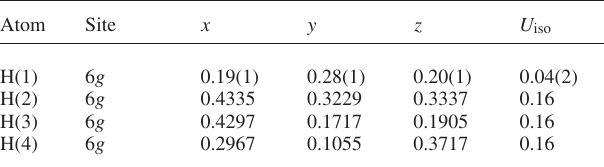
Table 2. Atomic coordinates and displacement parameters (in Å 2 )